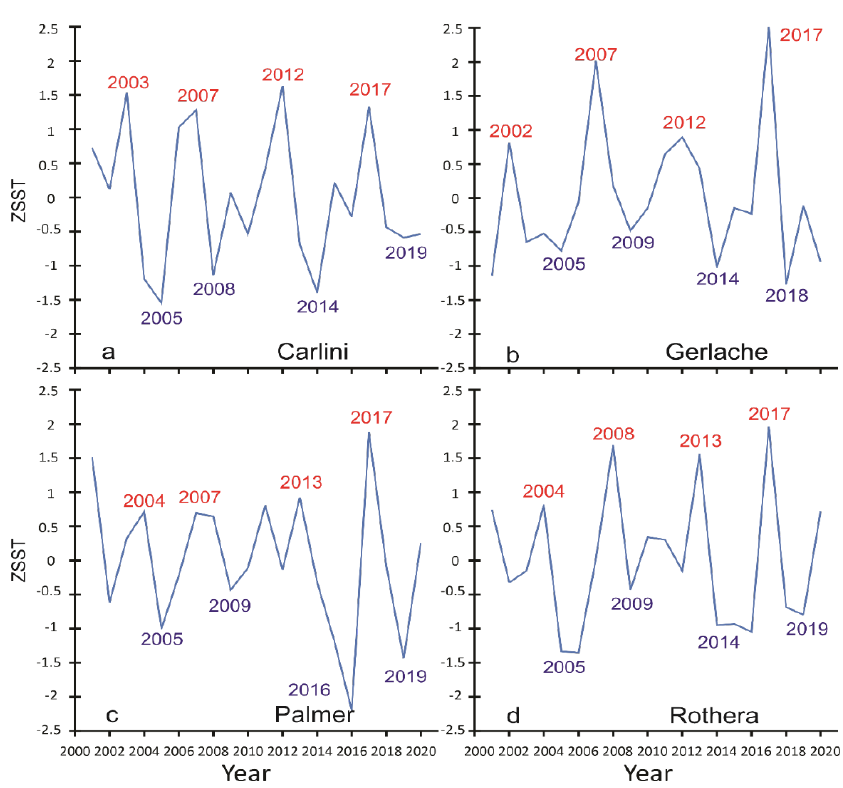
Figure 4. Time series of standardized SST anomaly at ( a ) Carlini, ( b ) Gerlache, ( c ) Palmer, and ( d ) Rothera sites. Red and blue numbers indicate the year of occurrence of warm and cool episodes, respectively.